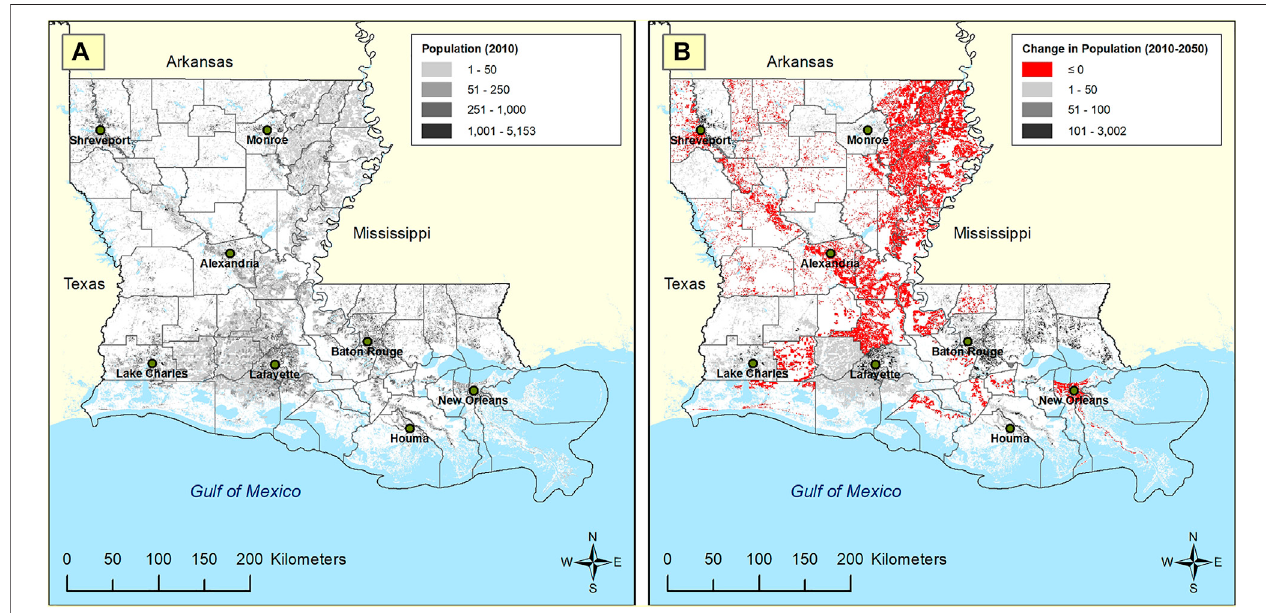
FIGURE 3 | Population by census block: (A) 2010, and (B) change in population from 2010 to 2050. Source: Mosta fi z et al. (2021a), Mosta fi z et al. (2021b).